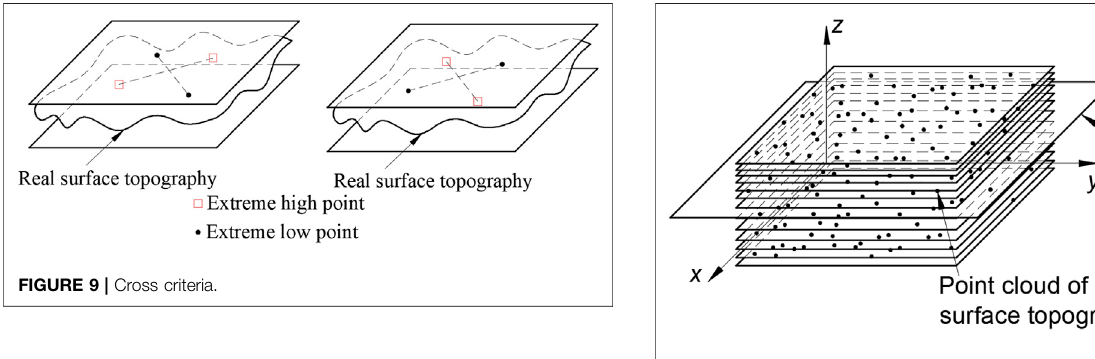
FIGURE 11 | Schematic diagram of hierarchical